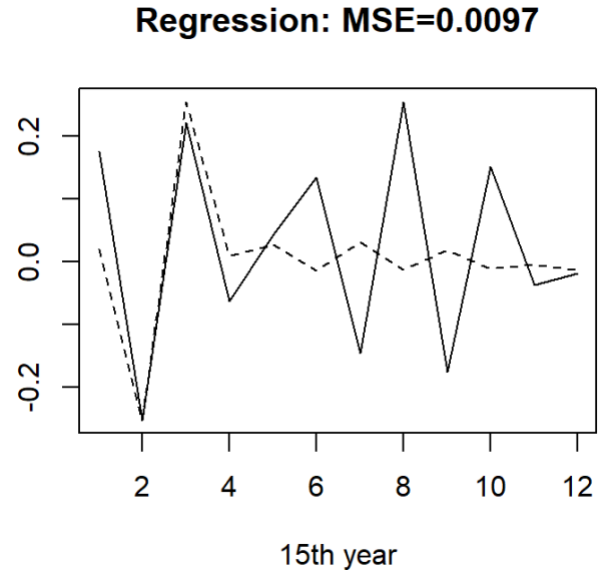
Figure 9. The curves of the true value (solid line) and FNR model (dotted line) with MSE = 0.0097.